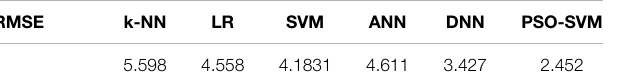
TABLE 4 | Comparison of different SOH prediction